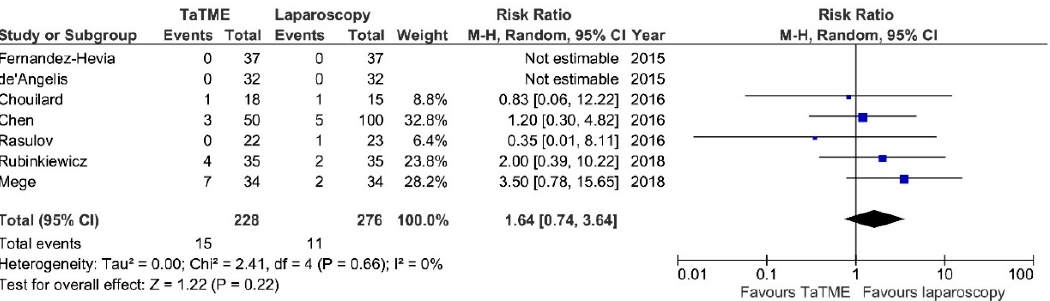
Figure 4. Intraoperative Adverse Effects. CI—Confidence Interval; df—degrees of freedom, M-H—Mantel-Haenszel test. WMD and RR are presented on the graphs as squares, and overall WMD and RR is presented as diamond.